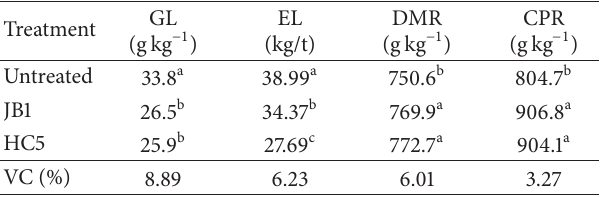
Table 6: Mean values of gas losses (GL), effluent losses (EL), dry matter recovery (DMD), and crude protein recovery (CPR) of Tanzania grass